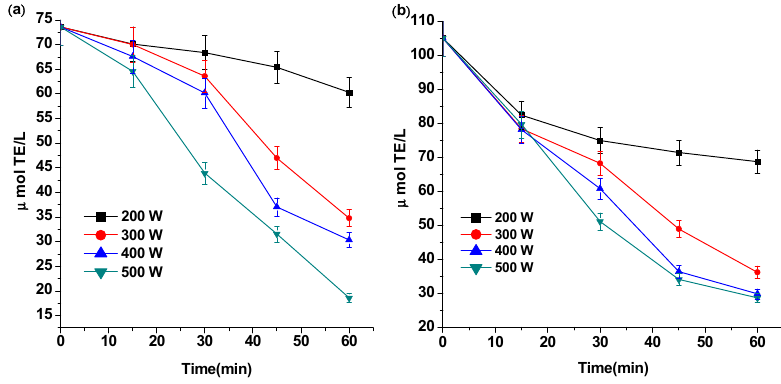
Figure 3. FRAP reducing power ( a ) and DPPH scavenging activity ( b ) changes of solution containing Pg-3-glu after treated by ultrasound. Antioxidant capacity expressed as µ mol of trolox equivalents/L sample ( µ mol · TE/L).